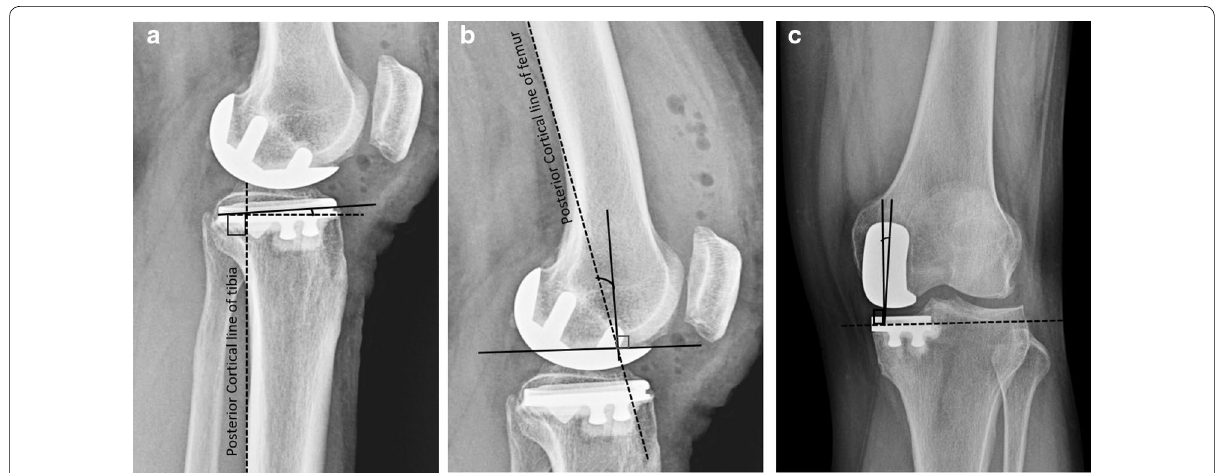
Fig. 4 a Tibial component slope is determined by the angle between the line perpendicular to posterior tibial cortex and the tibial component sagittal axis; b Femoral component sagittal alignment is determined by the angle between the line perpendicular to the component part placed on distal femur cut and the posterior cortical line of femur; c Interprosthetic divergence is the angle between the line perpendicular to the tibial component coronal axis and the long axis of femoral